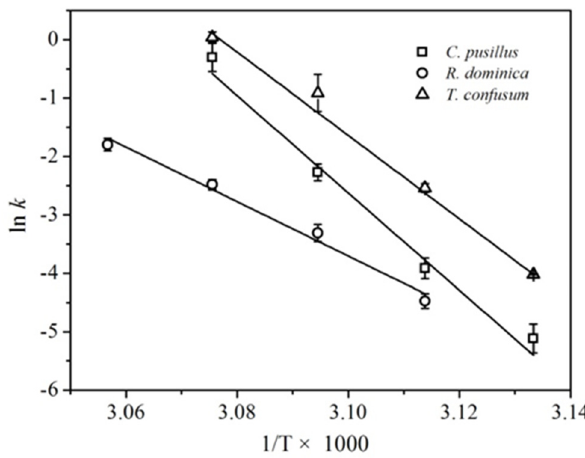
Figure 4. Arrhenius plot for temperature effects on thermal death rates of adult C. pusillus, R. dominica, and T. confusum.